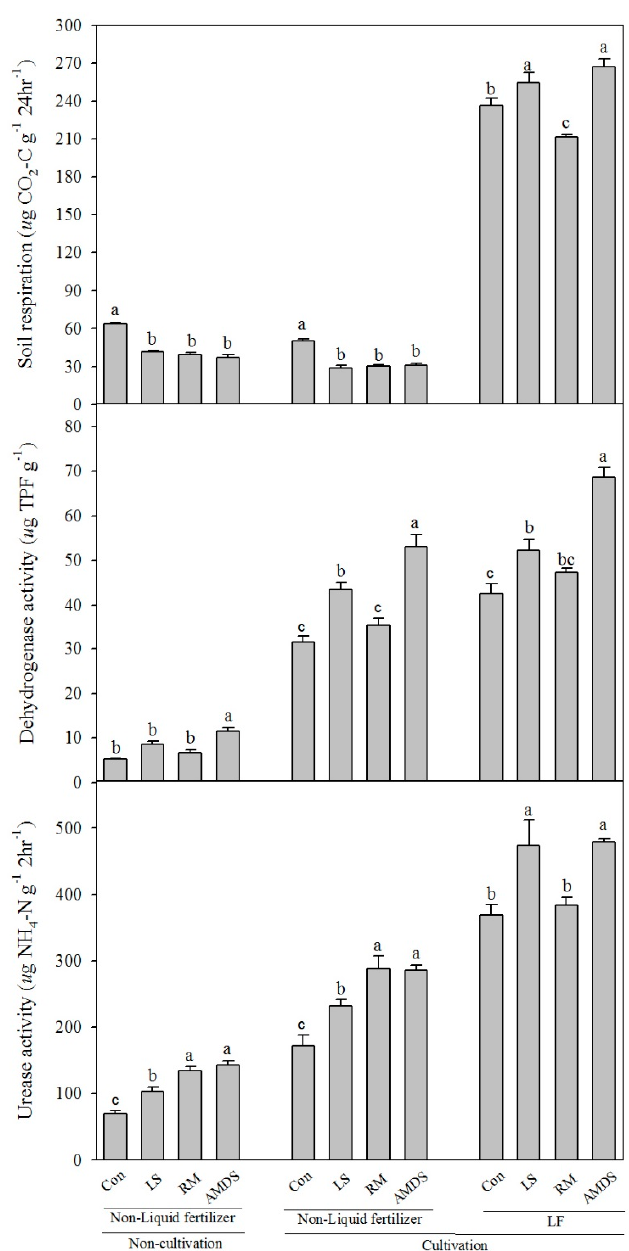
Figure 2. Changes in soil microbial and enzyme activity according to various combinations of treatments (Con, control; LS, limestone; RM, red mud; AMDS, acid mine drainage sludge). Different letters indicate significant differences at the 5% level according to Tukey’s test between amendments.